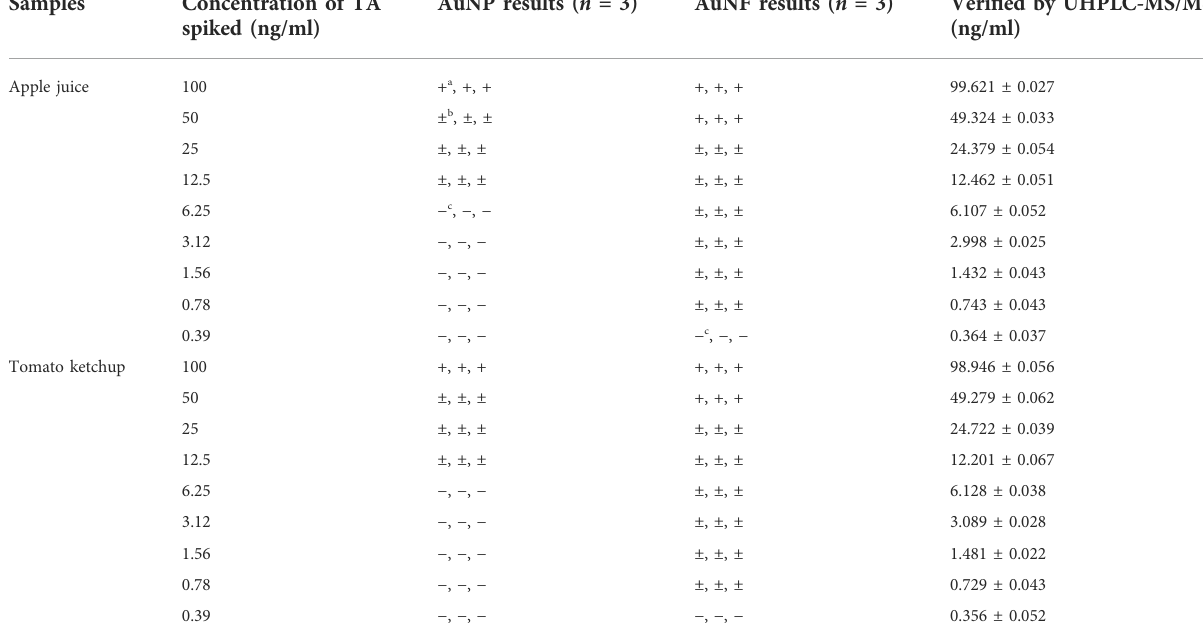
TABLE 1 Results of visual TA detection by the AuNP-based and AuNF-based LFIA in spiked samples. Samples Concentration of TA AuNP results ( n = 3) AuNF results ( n = 3) Veri fi ed by UHPLC-MS/MS spiked (ng/ml)